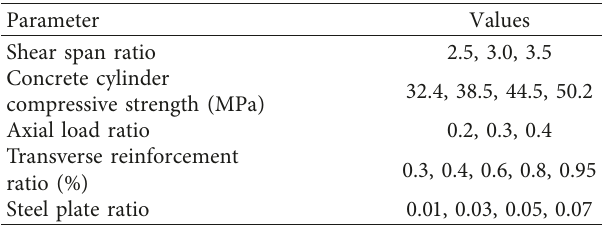
Table 4: Parameters of finite element models.